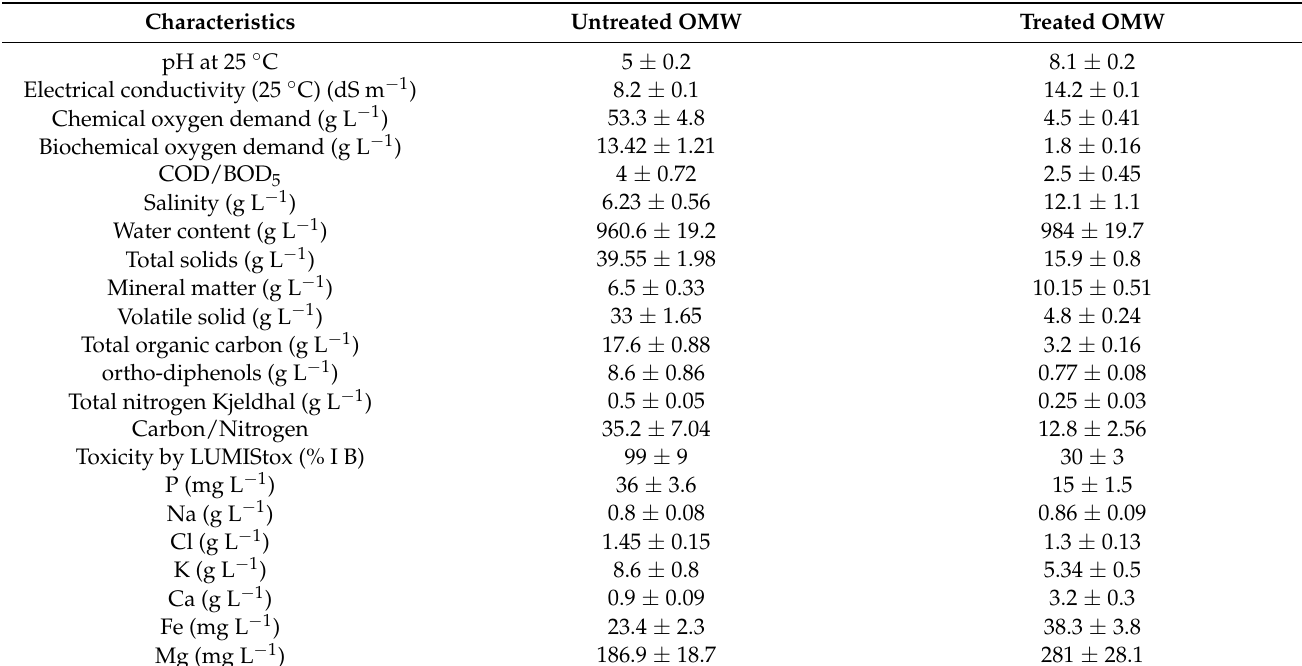
Table 2. Physiochemical characteristics of untreated and treated OMW. Adapted from Reference [17].